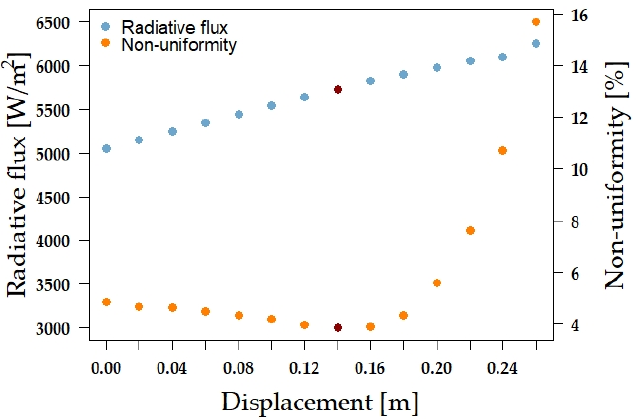
Figure 8. Relation between the radiative flux and the non-uniformity for different receiver’s displacement.